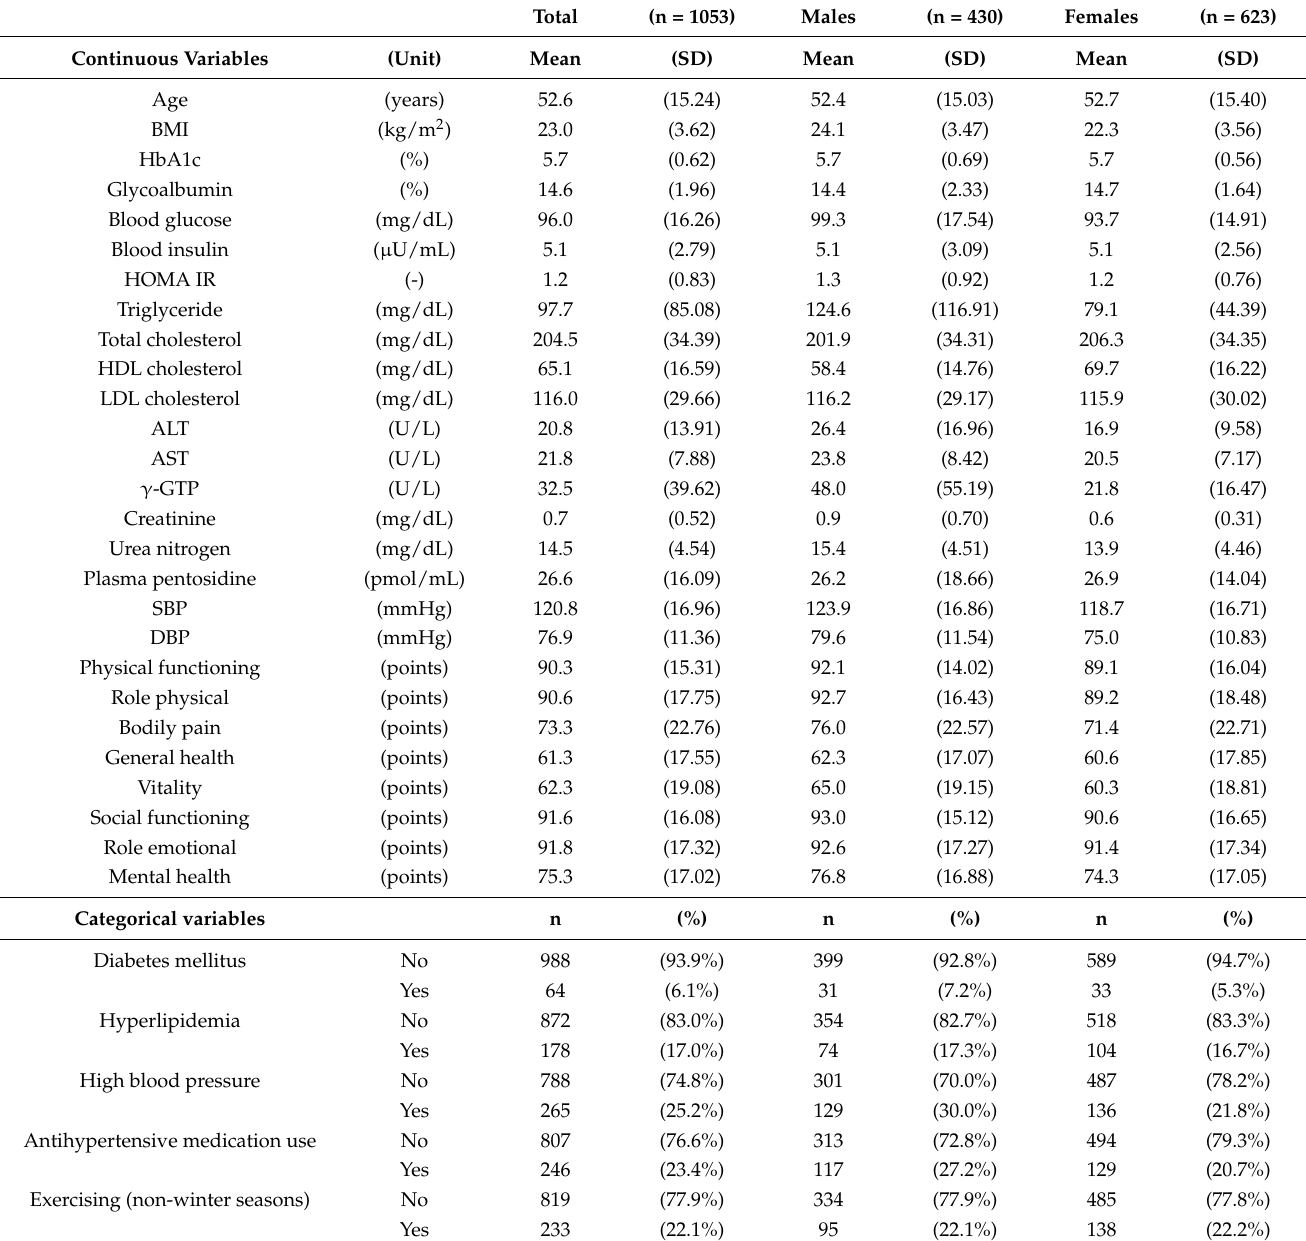
Table 1. Clinical characteristics of the study